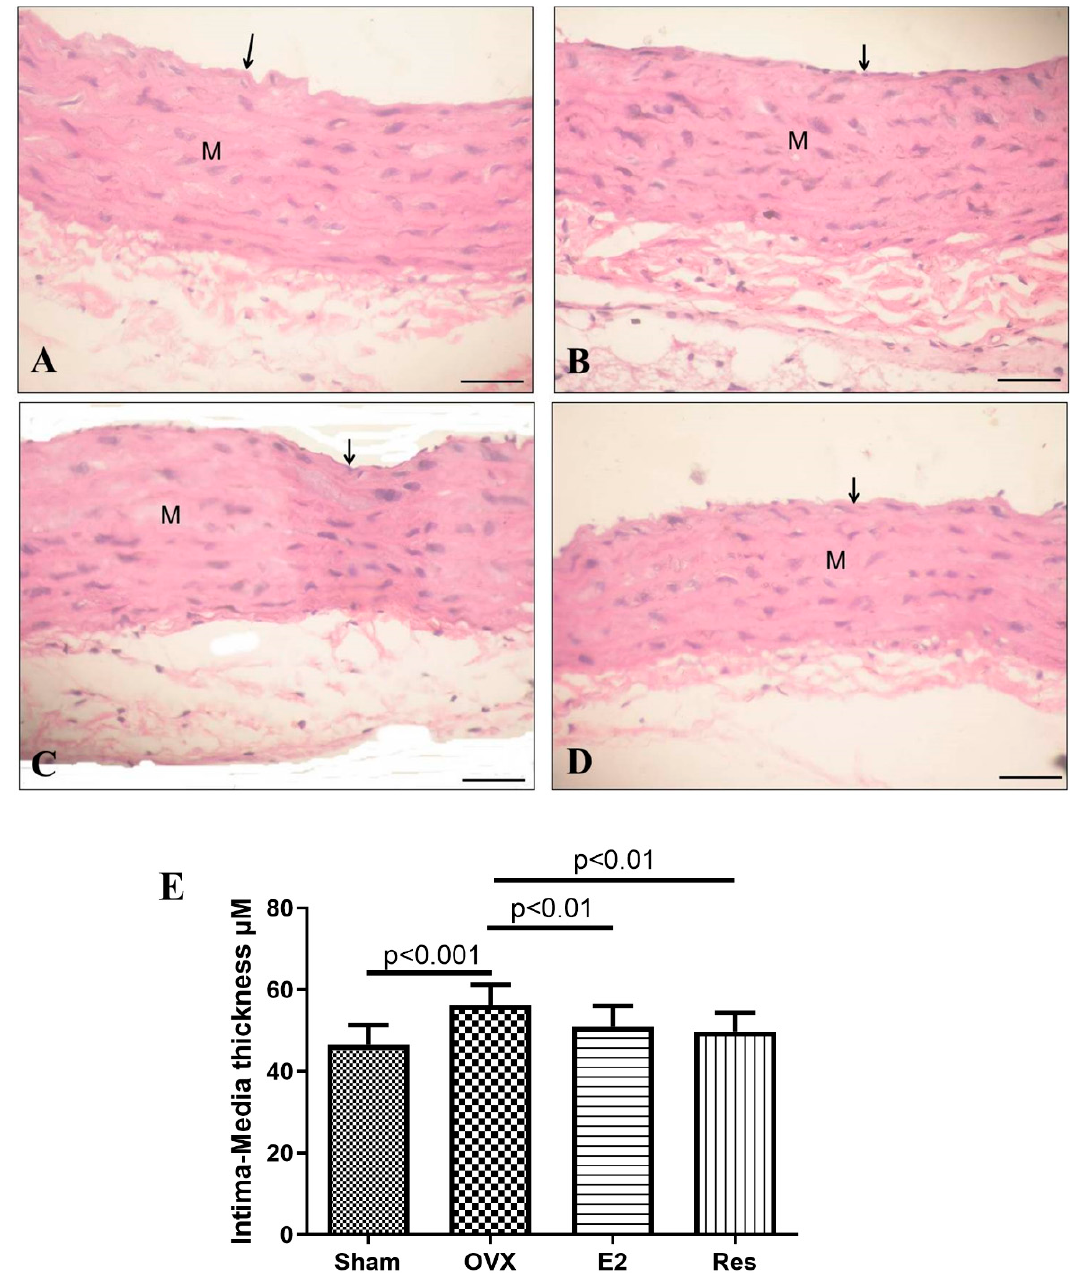
Figure 5. Resveratrol and E2 improved aortic intima media thickness, as shown by H&E stain. ( A ) The sham group showing a tunica intima that consists of a simple squamous epithelium (arrow) lining the interior surface of the vessel with an intact internal elastic lamina. A normal subendothelial layer of loose connective tissue is also shown. The tunica media (M) is made of smooth muscle cells and elastic fibers. ( B ) OVX rats showing signs of intimal injury as denoted by the separation of the endothelial layer. ( C ) Estradiol-treated rats and ( D ) resveratrol-treated rats. ( E ) Aortic intima media thickness. Graph shows mean ± SD. Scale bar 20 µ m. OVX: ovariectomized rats; E2: estradiol; Res: resveratrol.